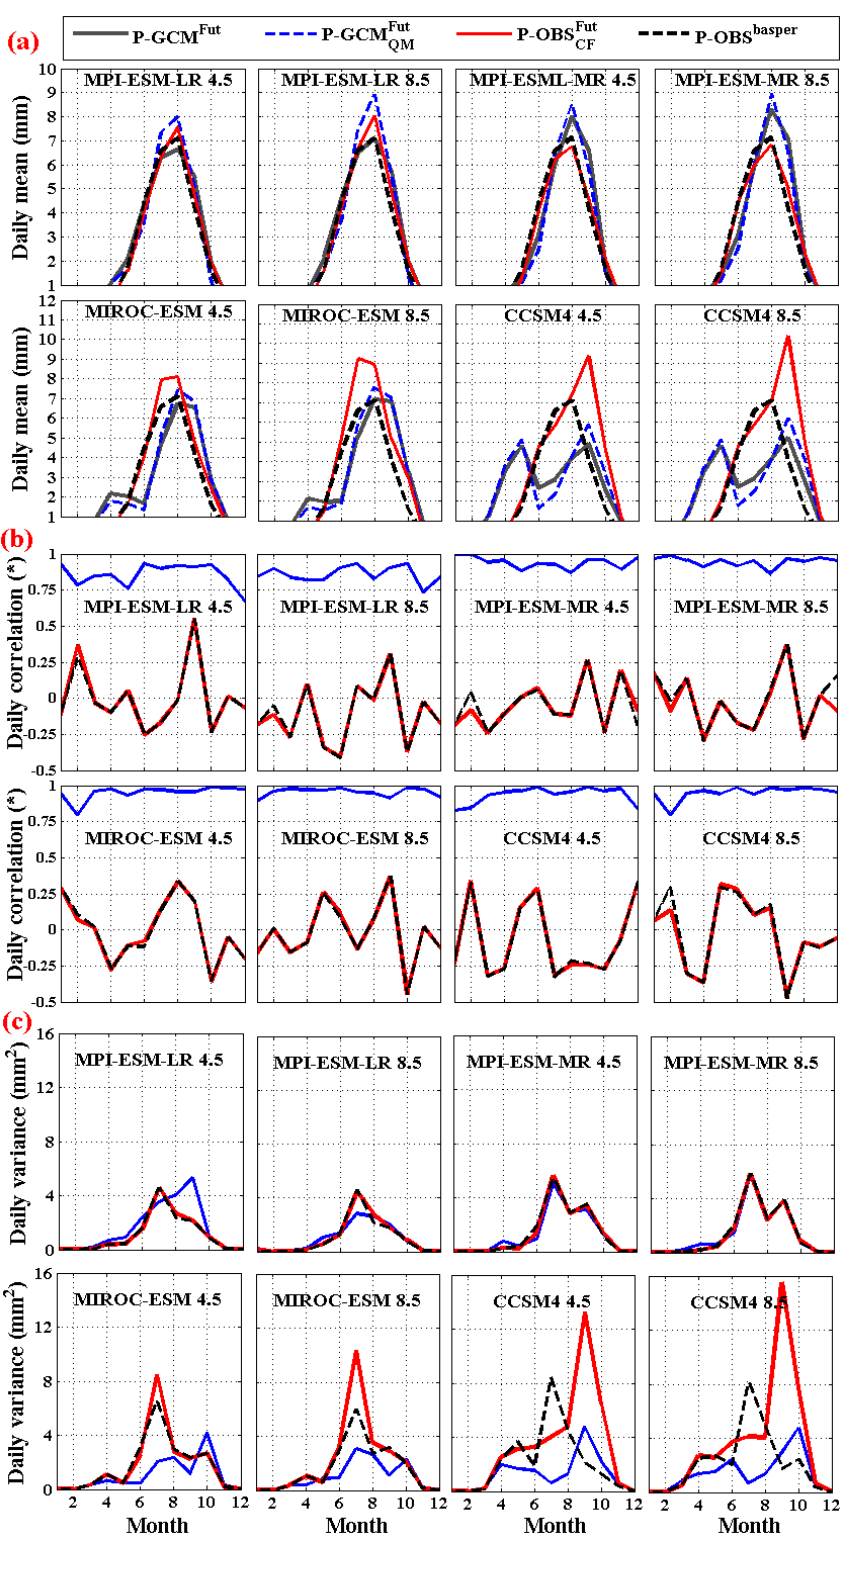
Figure 11. As in Fig. 9 but for the